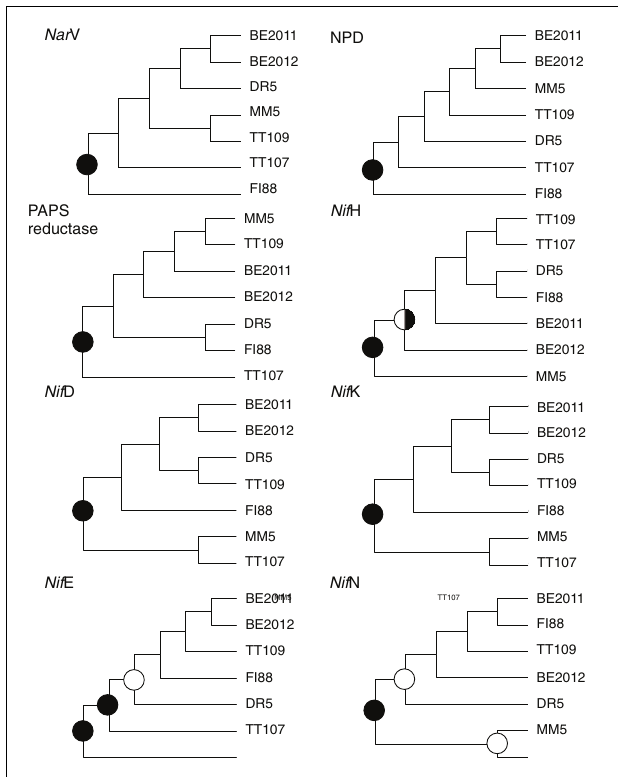
FIGURE 5 | Phylogenetic relatedness of the studied metagnomes revealed by each of the common functional genes. Branch support of the dendrograms was derived from 1000 permutations of Jackknife resampling. Nodes supported by 50–69% (open circles), 70–89% (half-filled circles), and 90–100% (filled circles) of the permutated trees are